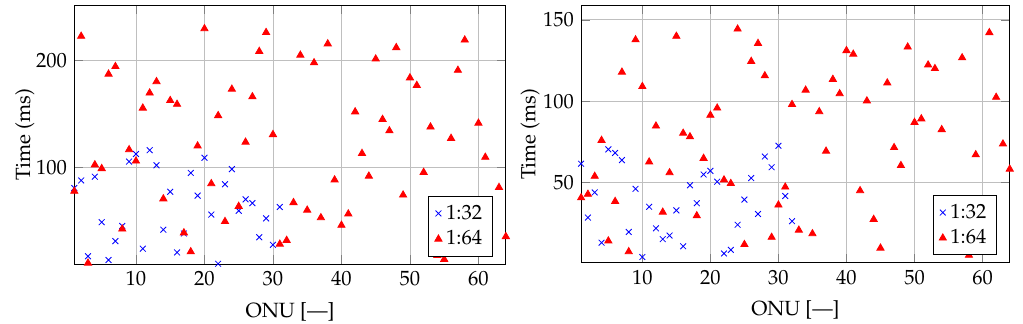
Figure 2. Graph of activation time for EPON 32/64 units and 20 km ODN.